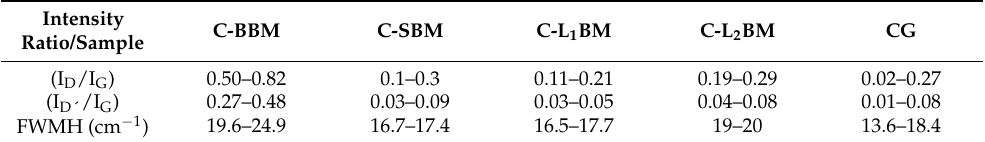
Table 6. Variation ranges of the intensity ratios I D /I G and I D’ /I G and FWHM of the G band for all the samples investigated.